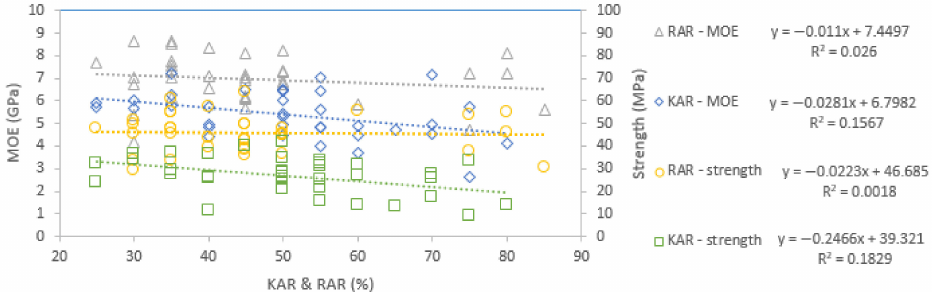
Figure 10. KAR and RAR vs. bending MOE and